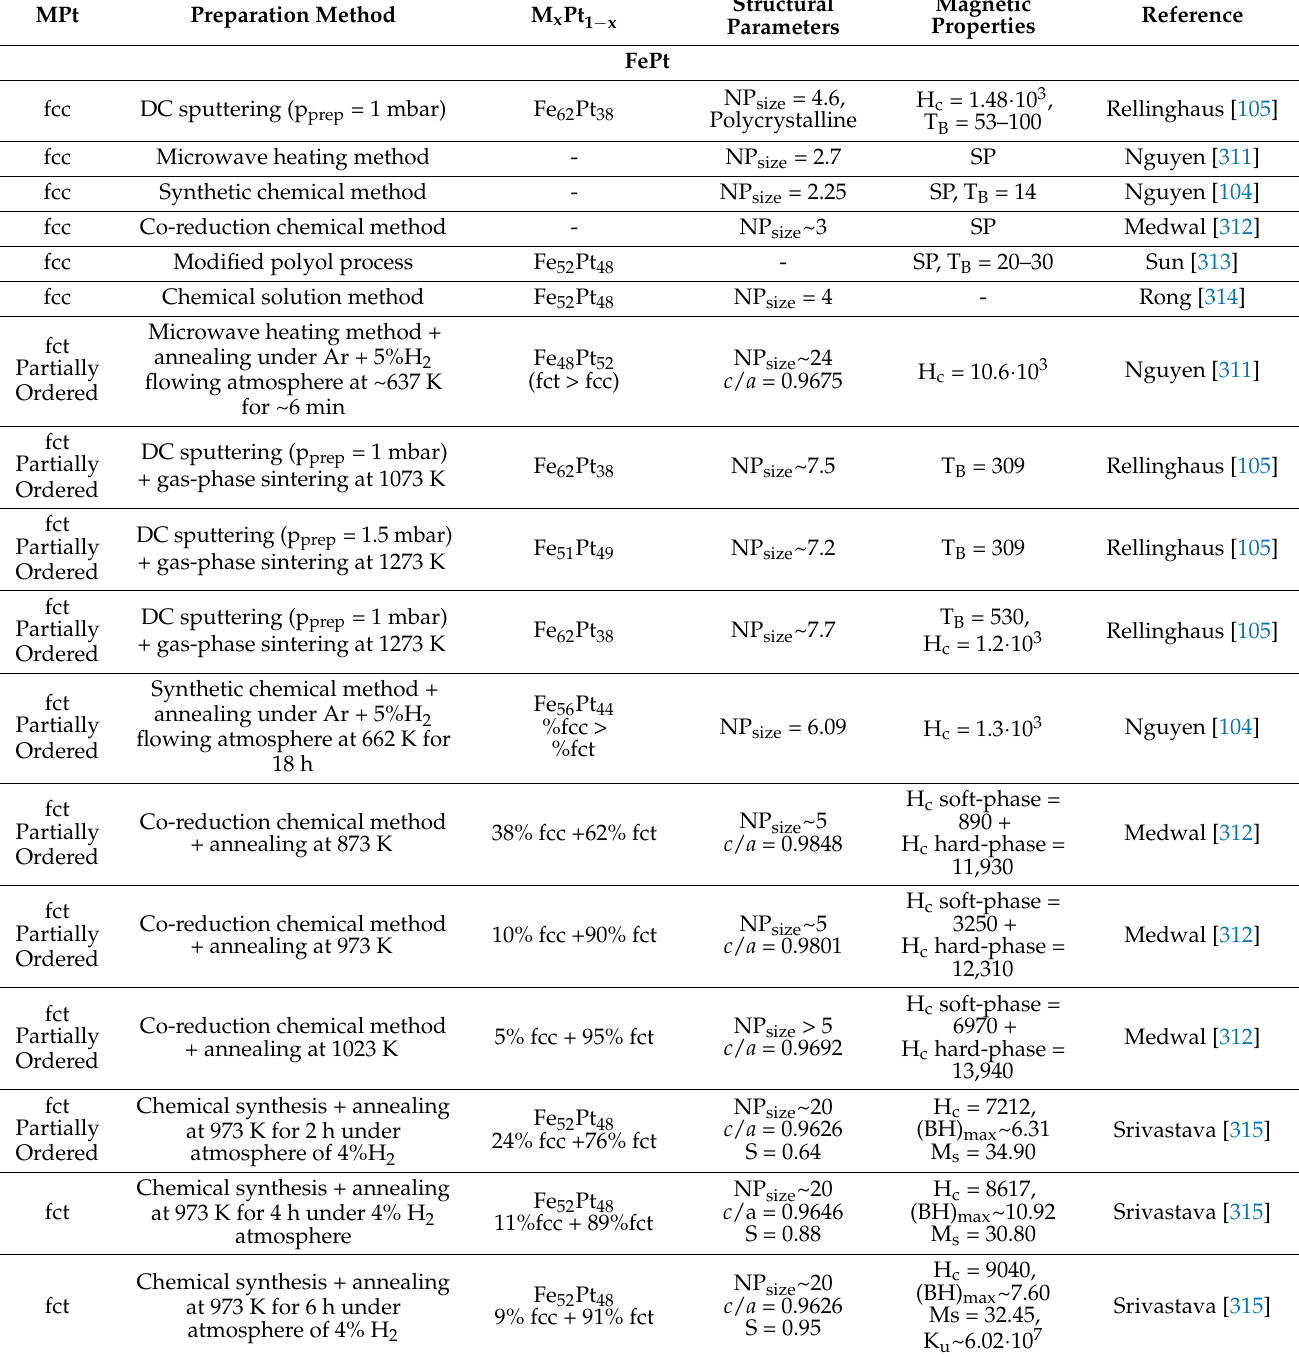
Table 4. Available experimental data on MPt (M = Fe, Co) nanoparticles (NPs). M x Pt 1 − x indicates the composition of the system. Structural parameters include size (NP size , in nm), shape of the NPs, c / a ratio and the ordered parameter (S) of NPs. Magnetic proprieties considered in the table include the magnetic state (FM = ferromagnetic, SP = superparamagnetic), the saturation magnetization (M S , in emu/cm 3 ), the coercivity (H c , in Oe), the uniaxial magnetocrystalline anisotropy energy constant (K u , in erg/cm 3 ), the blocking temperature for the superparamagnetic state (T B , in K) and the maximum energy product ((BH) max in MGOe). Magnetic properties are recorded at r.t. and reported in the centimeter/gram/second system